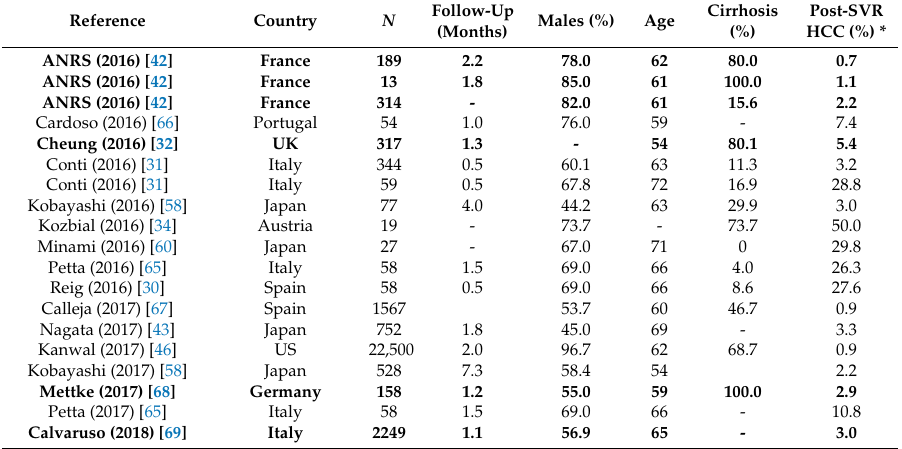
Table 2. Studies reporting incidence of hepatocellular carcinoma following post-sustained virological response in chronic hepatitis C patients treated using direct-acting antiviral therapy (adapted from Baumert et al., 2017 [49]). Prospective studies are indicated using bold